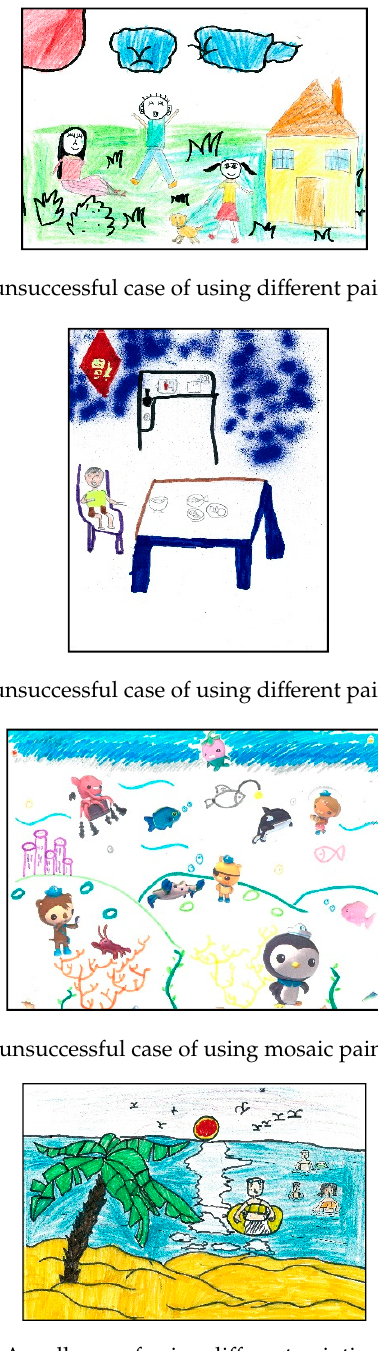
Figure 4. A well case of using different painting materials.